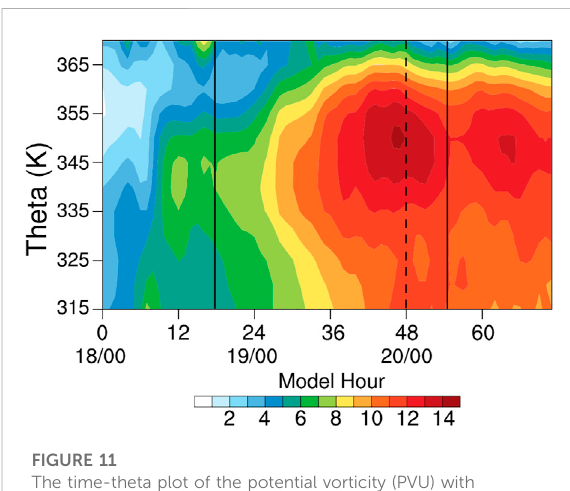
FIGURE 11 The time-theta plot of the potential vorticity (PVU) with isentropic surfaces in the 100 km × 100 km typhoon-centered region. The reference lines represent the same meaning as those in Figure